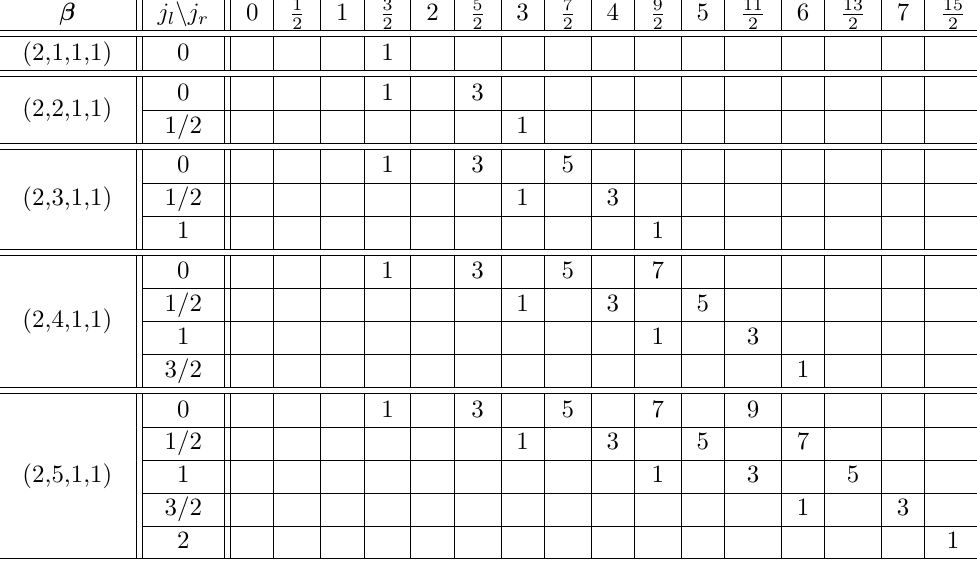
for local dP 3 j l ,j r